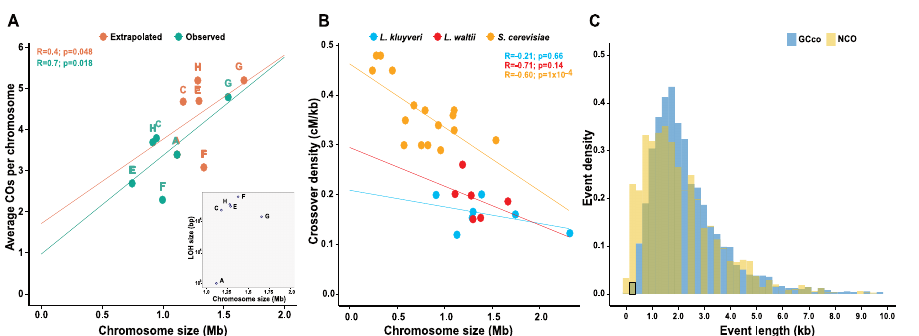
Fig 2. L . waltii recombination events. A . Frequency of crossovers in L . waltii are related to chromosome size. The ‘observed’ version corresponds to the average number of CO detected compared to the studied fraction of each chromosome, i . e ., excluding the LOH regions (intercept = 0.72, slope = 2.65 x 10 − 6 ). The ‘extrapolated’ version represents the corrected number of COs relative to the actual chromosome size (intercept = 1.4, slope = 2 x 10 − 6 ). The corrected CO number was estimated by extending the CO rate (3.4 CO/Mb) to the whole chromosome. [Inset: cumulative sizes of regions under LOH relative to the actual chromosome size.] B . Recombination rate (cM/kb) plotted against chromosome size for L . waltii with the extrapolated values (R = -0.71, p = 0.14), L . kluyveri (R = -0.21, p = 0.66) and S . cerevisiae (R = -0.6, p = 0.6, p = 1 x 10 − 4 ). L . kluyveri data from [61], S . cerevisiae data pooled from [68] and [33]. C . Distribution of gene conversion tract sizes associated to crossovers (GCco) and noncrossovers.